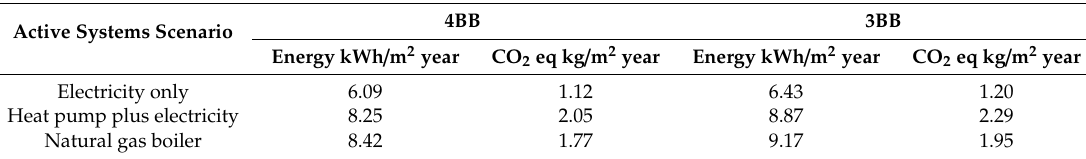
Table 10. Embodied cradle-to-grave impacts of the active technical systems: primary energy and CO 2 equivalent emissions for 4BB and